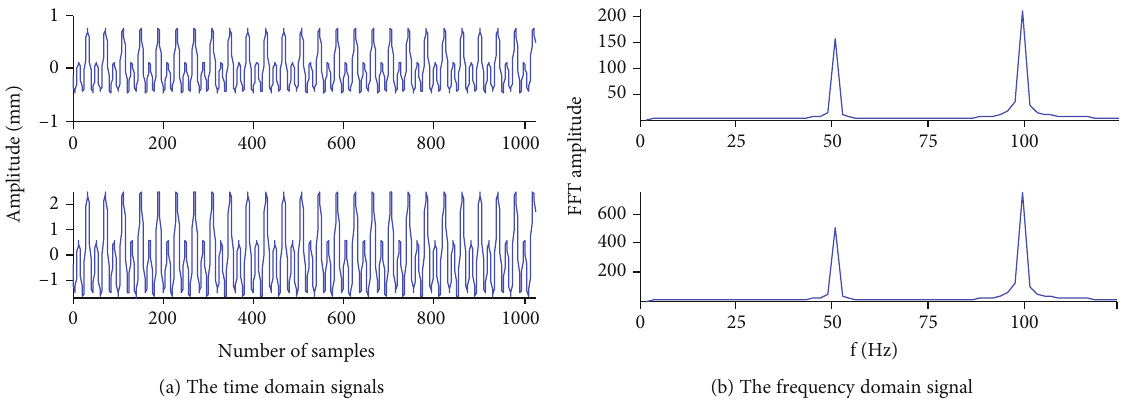
Figure 2: The time – frequency waveform of mixed